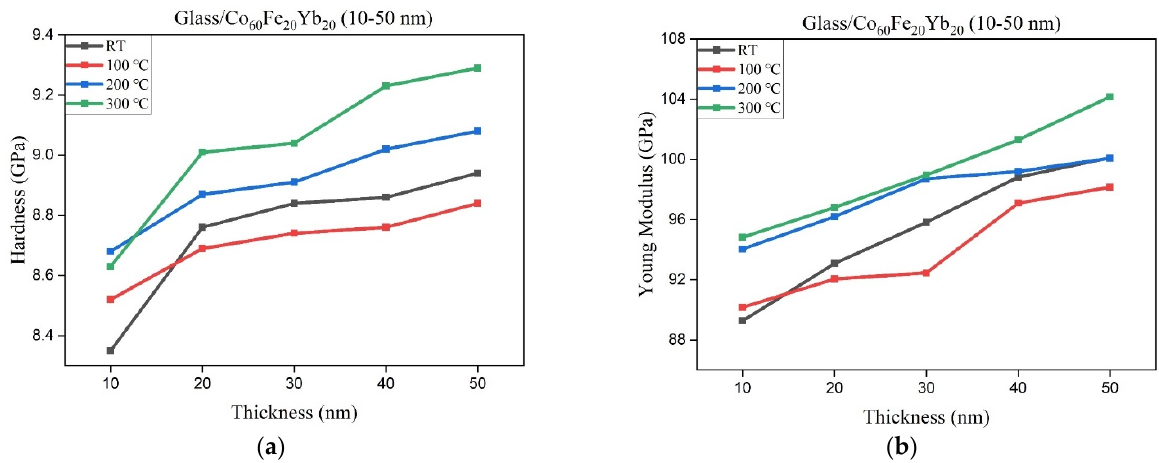
Figure 5. Nano-indentation of CoFeYb thin films. ( a ) Hardness and ( b ) Young’s modulus.